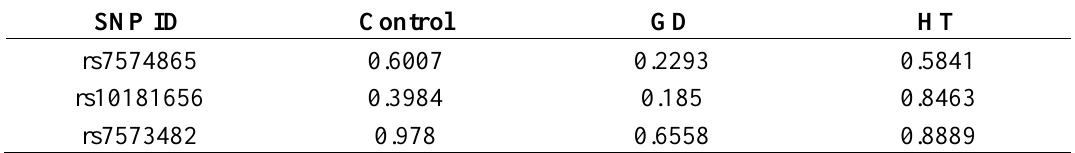
Table 1. Hardy-Weinberg p value of the three SNPs (single nucleotide polymorphisms) in the STAT4 gene. GD, Graves’ disease; HT, Hashimoto’s thyroiditis.